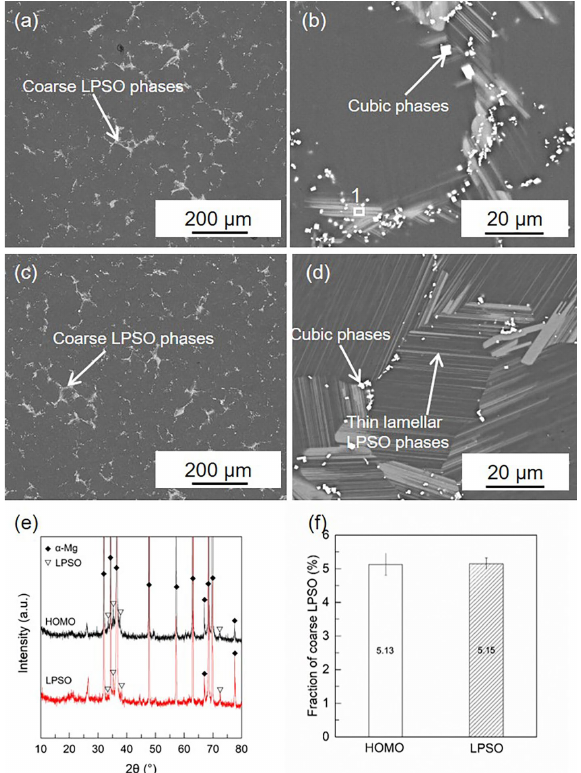
Figure 1. SEM images and XRD patterns of HOMO and LPSO samples: ( a , b ) SEM images of HOMO, ( c , d ) SEM images of LPSO samples, ( e ) XRD patterns of HOMO and LPSO samples, and ( f ) volume fraction of coarse LPSO phases.